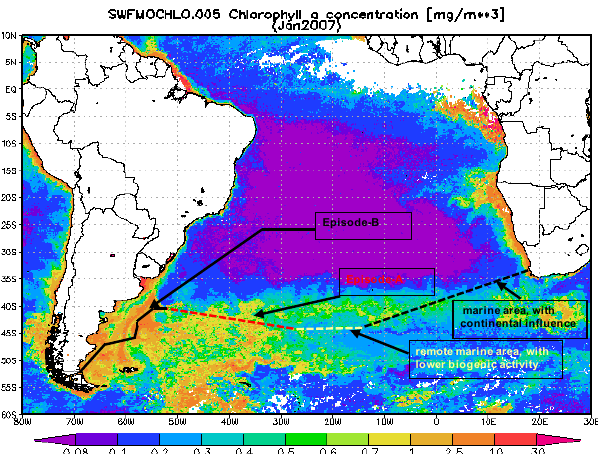
Figure 5. Two distinct phytoplankton bloom episodes are presented on a SeaWiFS chlorophyll a map of the South Atlantic Ocean dur- ing January 2007 along with the cruise track (http://disc.sci.gsfc.